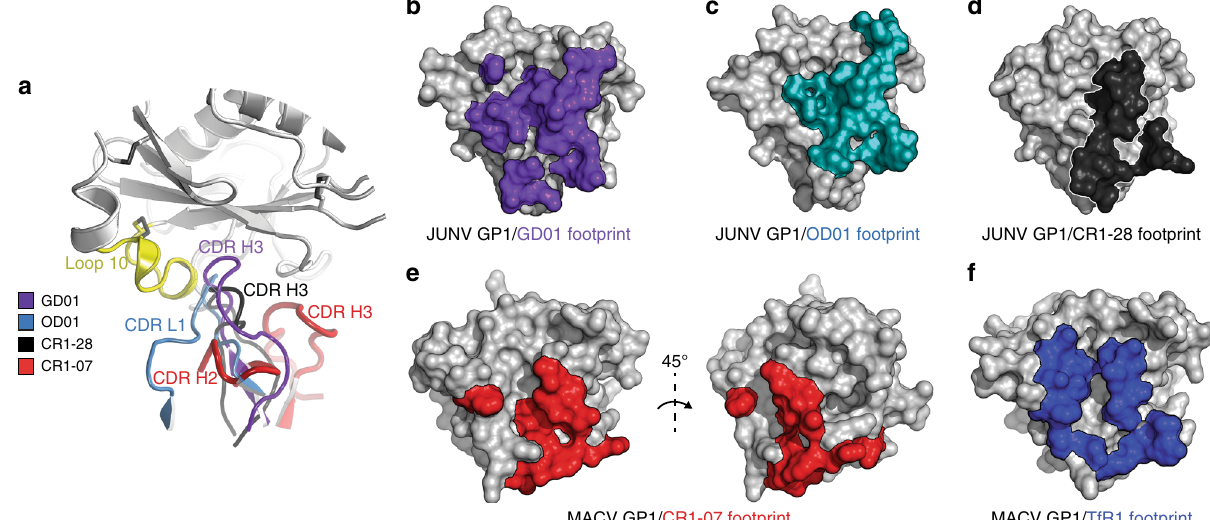
Fig. 6 Mechanism for ef fi cient MACV cross-neutralization. a Ribbon diagram of MACV GP1 (gray) with loop 10 shown in yellow, and CR1-07 CDR H2 and CDR H3 (as determined in the MACV GP1/CR1-07 Fab complex) in red. To allow for comparison of antibody CDR segments, the structures of the JUNV GP1/GD01 Fab complex (PDB: 5EN2), 14 of the JUNV GP1/OD01 complex (PDB: 5NUZ), 15 and of the JUNV GP1/CR1-28 Fab subcomplex were overlaid onto MACV GP1 by aligning the GP1s. JUNV GP1 used for alignment of the complexes is omitted for clarity. b Surface representation of JUNV GP1 (PDB: 5EN2, 14 gray) with GD01-interacting residues shown in purple. c Surface representation of JUNV GP1 (gray) with OD01-interacting residues shown in light blue. d Surface representation of JUNV GP1 (gray) with CR1-28-interacting residues shown in black. e Surface representation of MACV GP1 (gray) with CR1-07- interacting residues shown in red. f Surface representation of MACV GP1 (PDB: 3KAS, 13 gray) with TfR1-interacting residues shown in dark